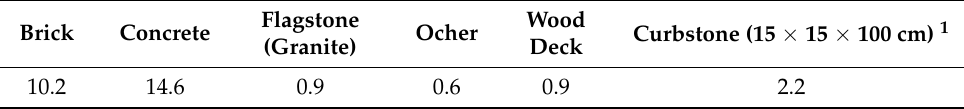
Table 6. Carbon emissions per unit pavement area by paving materials production (kg/m 2